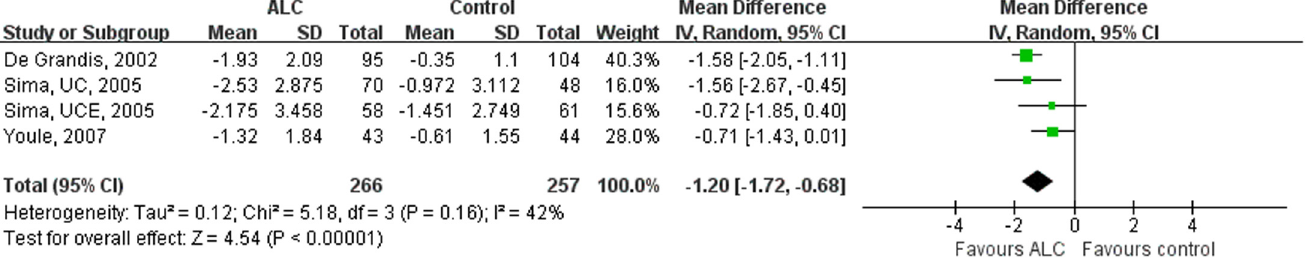
Fig 2. Overall Meta-analysis on the VAS Scores. Patients receiving ALC showed significantly more reduction in VAS scores than those receiving placebo. The values presented referred to the change of VAS scores from baseline. VAS = Visual Analogue Scale; ALC = acetyl-l-carnitine; UCE = U.S.- CanadianEuropean Study; UC = U.S.-Canadian Study; SD = standard deviation; CI = confidence interval.